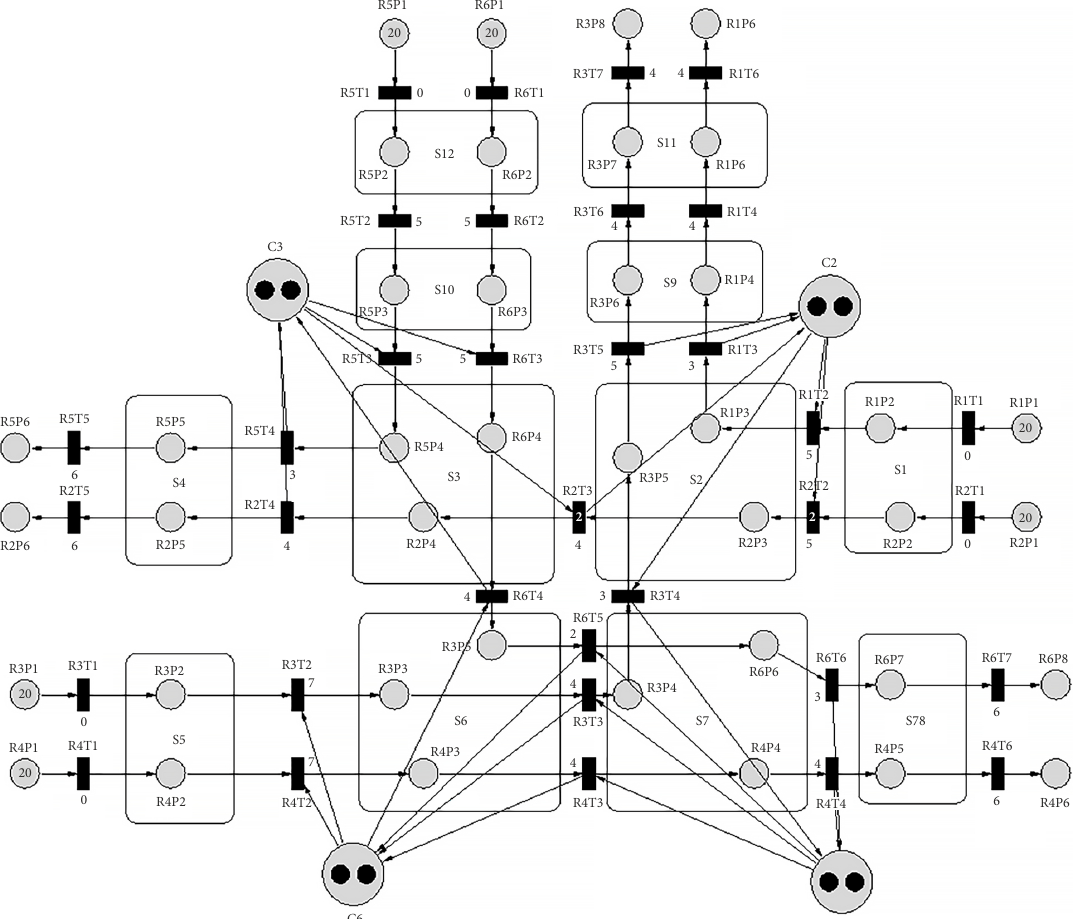
Figure 8. TSPN and CTSPN of the traffic in the Singapore